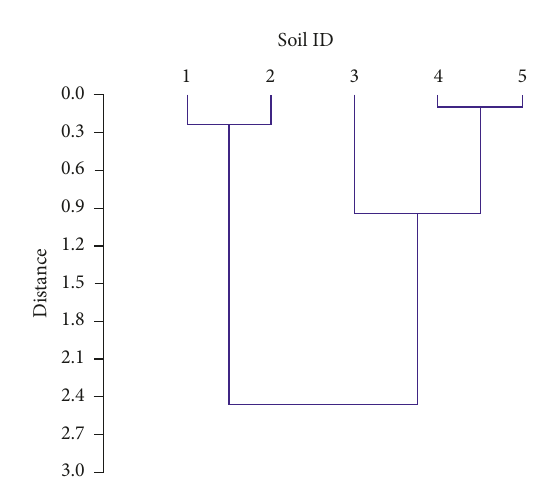
Figure 6: Hierarchical clustering based on ESR analysis. Ward’s